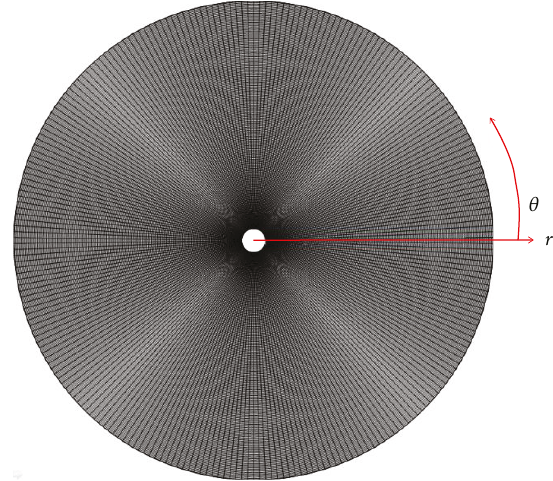
Figure 1: Schematic of computational